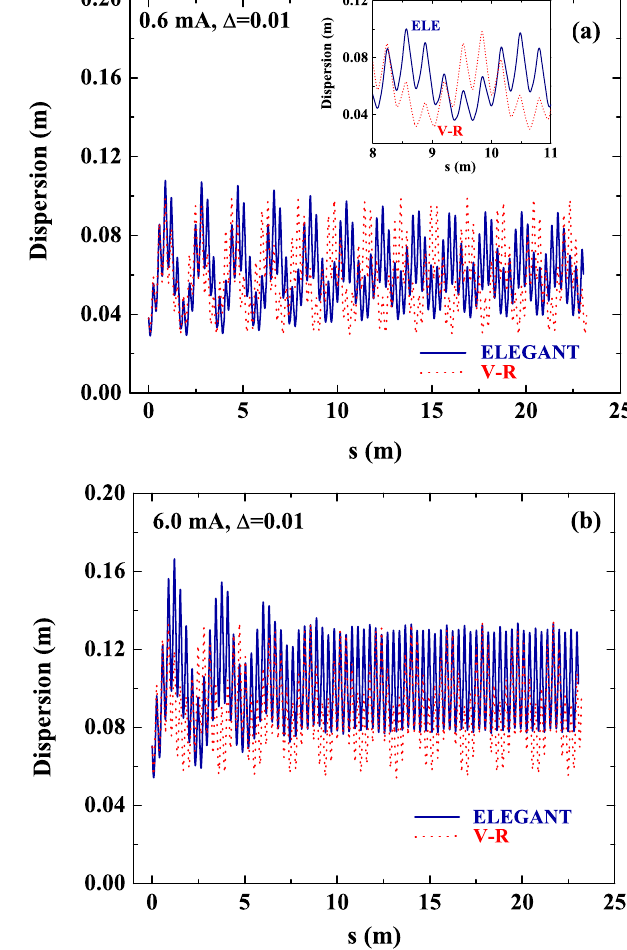
FIG. 6. Dispersion functions ( ELEGANT , solid curves; V-R equations, dotted curves) with space charge for (a) 0.6 mA and (b) 6.0 mA, at (cid:1) ¼ 0 : 01 over two turns in UMER. The disper- sion functions from ELEGANT appear to be shifting ahead of the V-R curves, but the inset in (a) indicates that this is not the